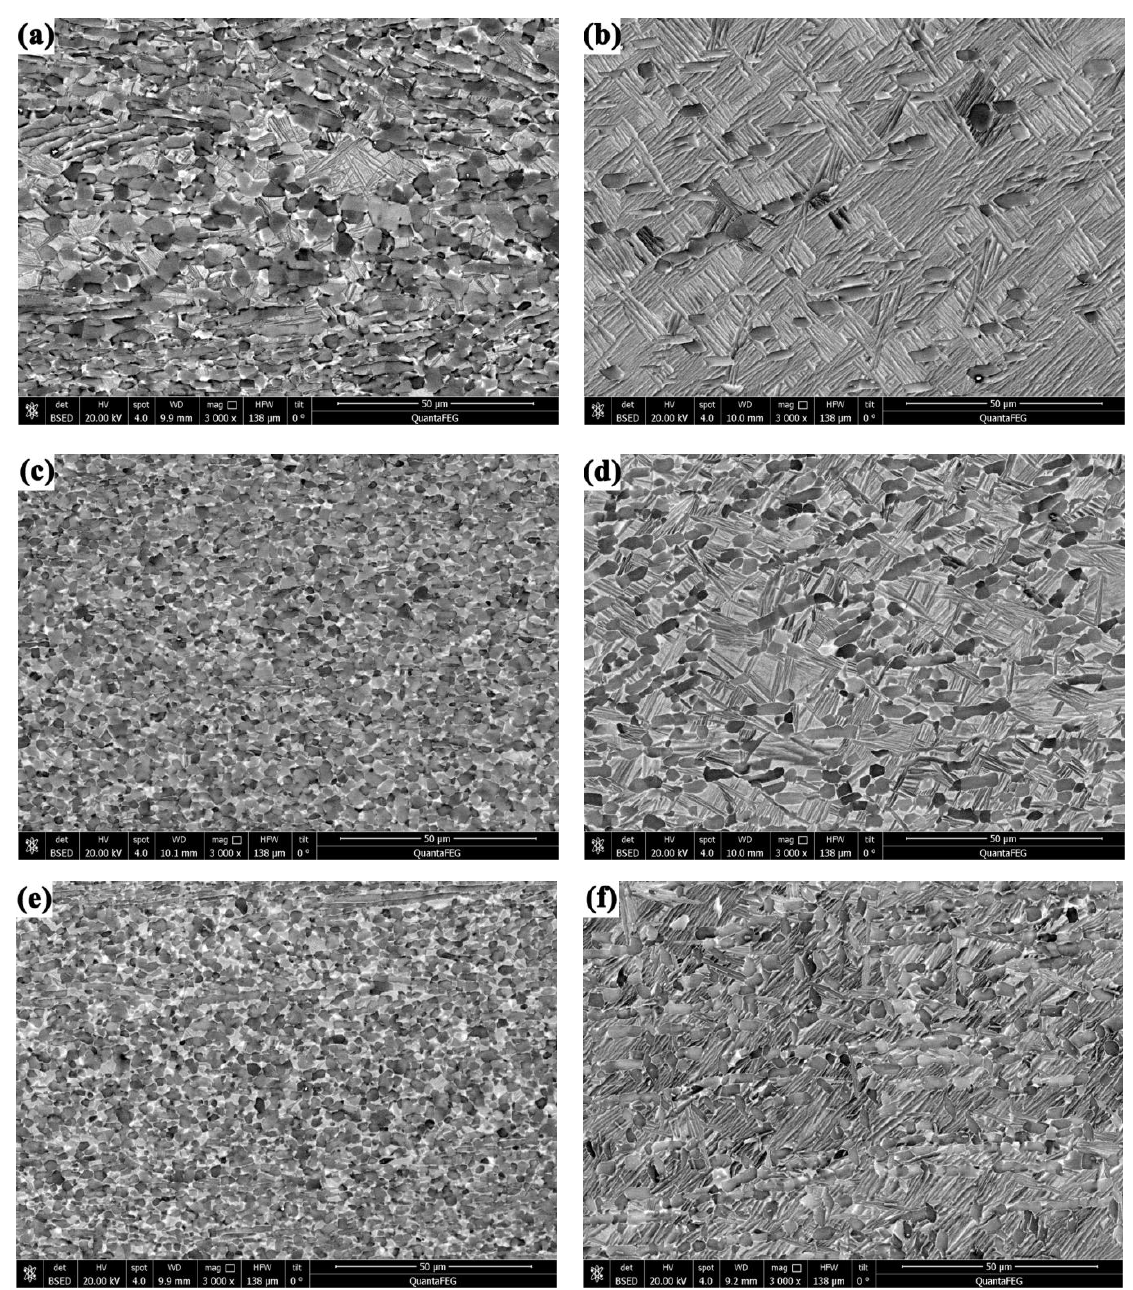
Figure 6. Microstructures of Ti-6Al-4V specimens deformed at ( a ) 900 ◦ C/10 − 3 s − 1 ; ( b ) 950 ◦ C/10 − 3 s − 1 ; ( c ) 900 ◦ C/5 × 10 − 3 s − 1 ; ( d ) 950 ◦ C/5 × 10 − 3 s − 1 ; ( e ) 900 ◦ C/10 − 2 s − 1 ; and ( f ) 950 ◦ C/10 − 2 s − 1